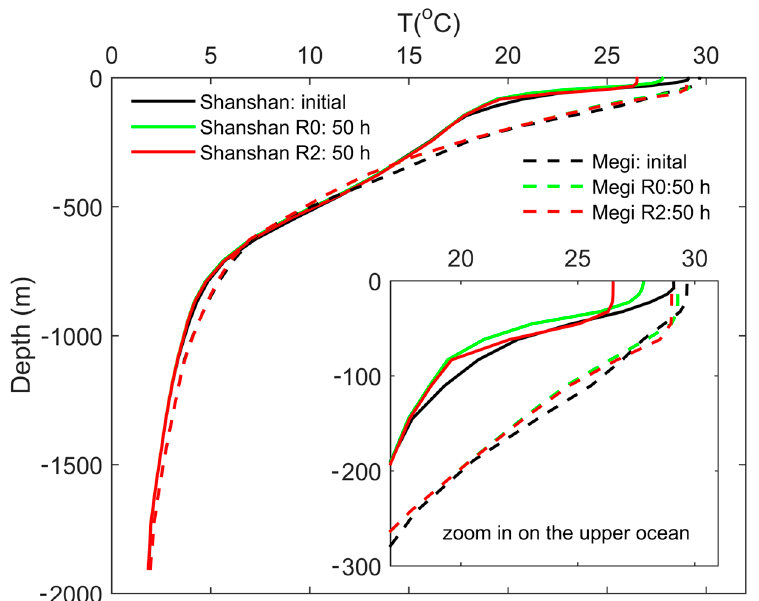
Figure 12. Water temperature profiles for Shanshan and Megi at the initial time (prior to the arrival of the TCs) and simulation time of 50 h (the arrival of the TCs) in R0 and R2. The green (red) solid and dotted lines represent the water temperature profiles in R0 (R2) at the simulation time of 50 h for Shanshan and Megi, respectively. The black solid and dotted lines display the water temperature profiles at the initial time for Shanshan and Megi, respectively. Note that the initial water temperature profiles of R0, R1, R2, and R3 for Shanshan (or Megi) are the same.